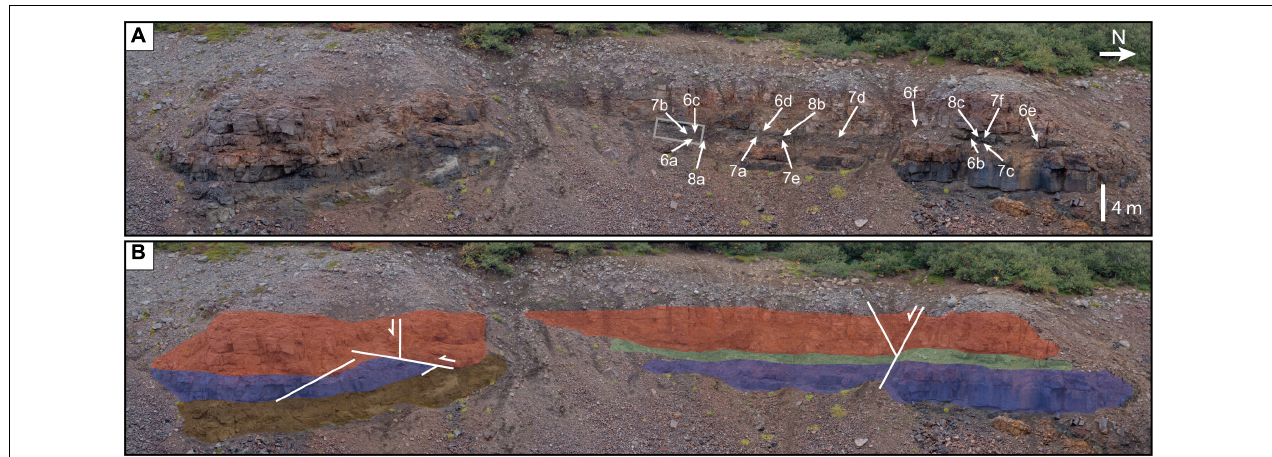
FIGURE 3 | Photograph (A) and interpretation (B) of the intrusive system. The upper red ignimbrite is coloured red, lower welded ignimbrite in blue, the tuffisitic sill in green, and magmatic intrusion in brown. The grey box shows the position of the photograph shown in Figure 4 , and labels indicate the position of the photographs in Figures 6 – 8 .